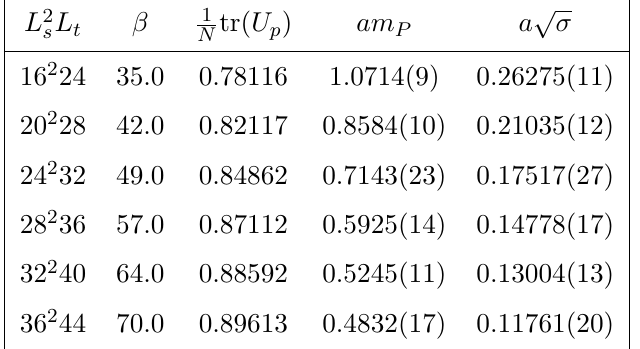
Table 15 . SO(7) average plaquette values, (cid:13)ux loop masses, and string